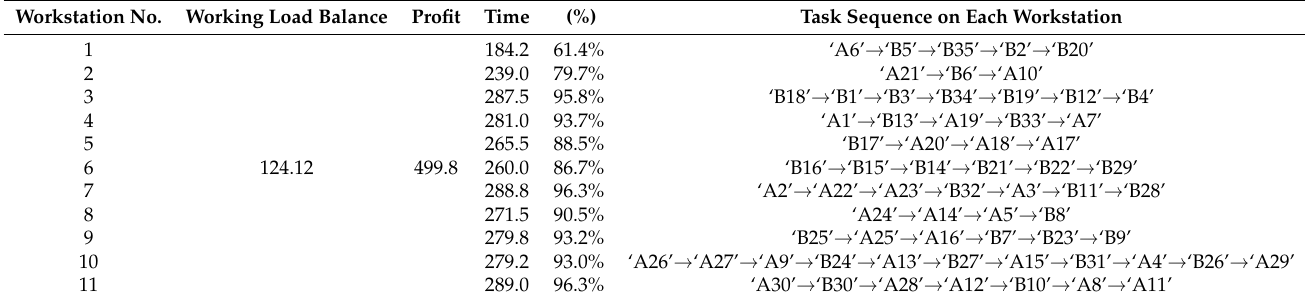
Table 10. One optimal sequence of the disassembly process ( CT 1 = 50, CT 2 =